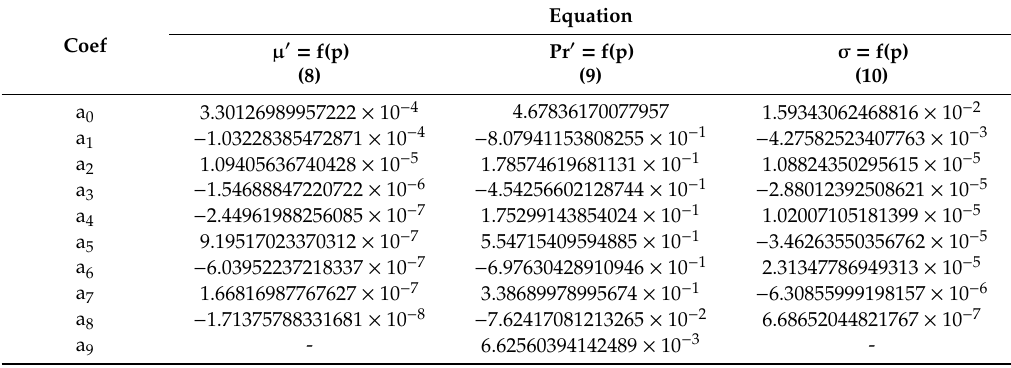
Table 5. Coe ffi cients of polynomials describing the dynamic viscosity coe ffi cient, Prandtl number, and surface tension of the R1234ze(E) refrigerant in the saturated liquid